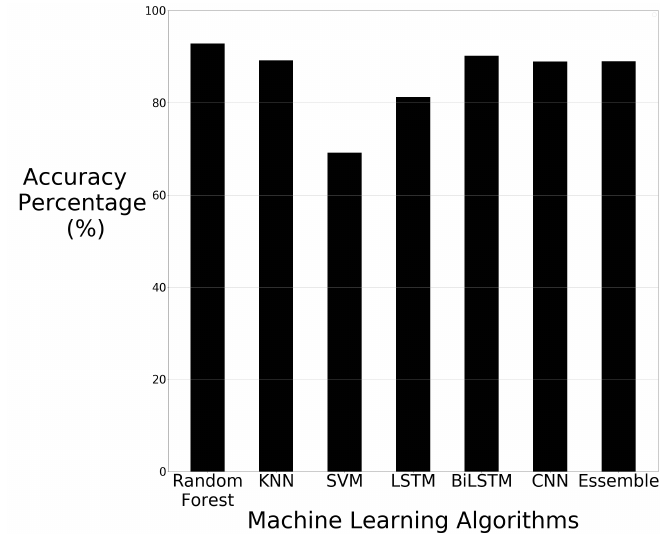
Figure 8. Machine learning results using data